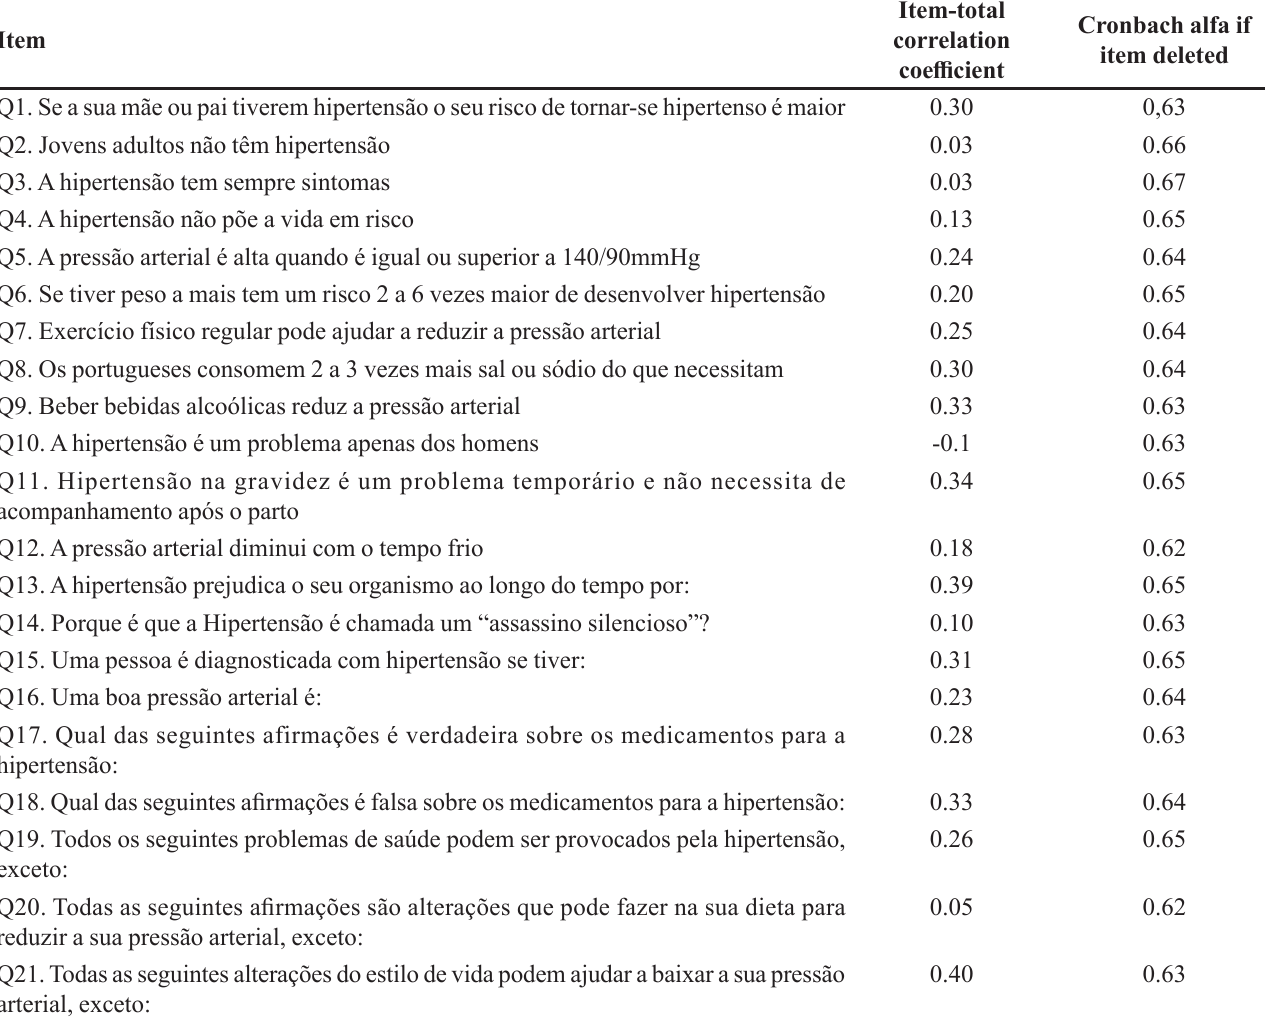
TABLE III - Internal consistency reliability of the Hypertension Knowledge Test